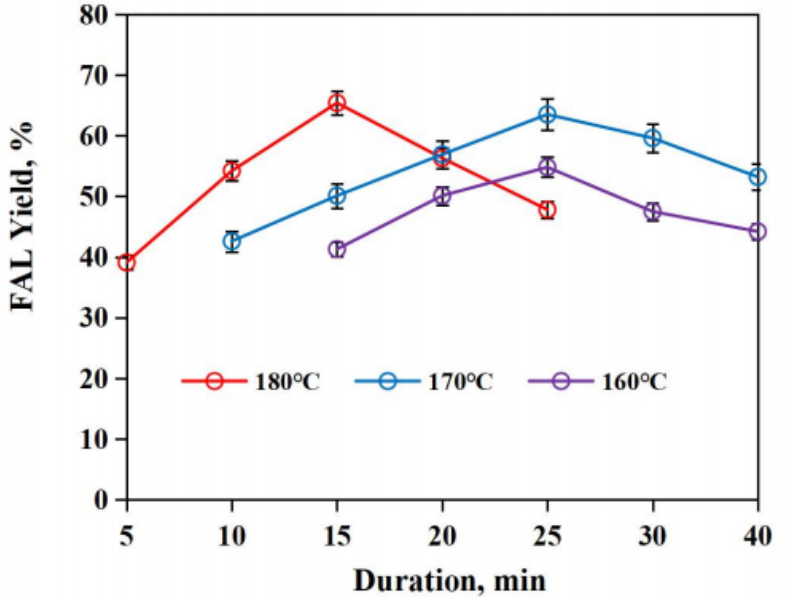
Figure 2. Effects of performance temperature (160, 170, and 180 °C) and duration (5–40 min) on the FAL yield in ChCl:LA–water (30:70, v / v ) (CS 75 g/L, Sn-SSXR 2 wt%). Tin-based heterogeneous catalysts (e.g., SO 42 − /SnO 2 -diatomite, SO 42 − /SnO 2 -kaoline, SO 42 − /SnO 2 -argil, SO 42 − /SnO 2 -CS, Sn-ZRD) could be utilized for efficient conversion of biomass or xylose into FAL (Table 1). Compared to Sn-SSXR, these three heterogeneous catalysts, including SO 42 − /SnO 2 -kaoline, SO 42 − /SnO 2 -argil, and Sn-ZRD, gave a lower titer of FAL. SO 42 − /SnO 2 -diatomite (3.6 wt%) could catalyze 75 g/L of corncob into FAL in a slightly high yield (68.9%) in a γ -GVL-water (6:4, v / v ) system containing 15 g/L ZnCl 2 at 170 ◦ C after 30 min. However, high-loading γ -valerolactone and ZnCl 2 were used. SO 42 − /SnO 2 -CS (1.2 wt%) could dehydrate xylose (75 g/L) into 200 mM FAL in ChCl:EG– water (5:95, v / v ) at 185 ◦ C within 20 min. However, FAL was obtained in a low yield (35.7%). Clearly, this established catalytic process by using Sn-SSXR as a chemocatalyst had a potential application for FAL